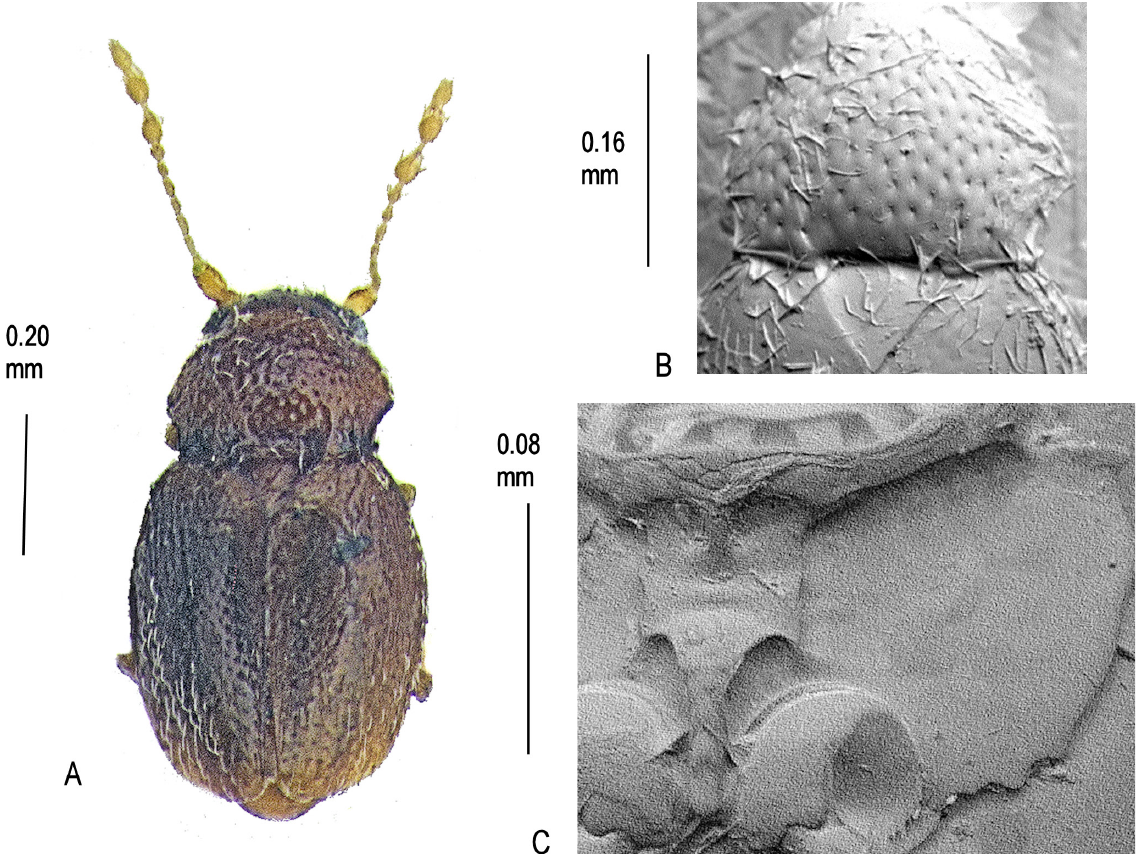
Fig. 55 . Cissidium marshallae Darby, 2019. A . Habitus. B . Pronotum, × 640. C . Mesoventrite showing median process of collar, mid-keel, keel and lateral margin,